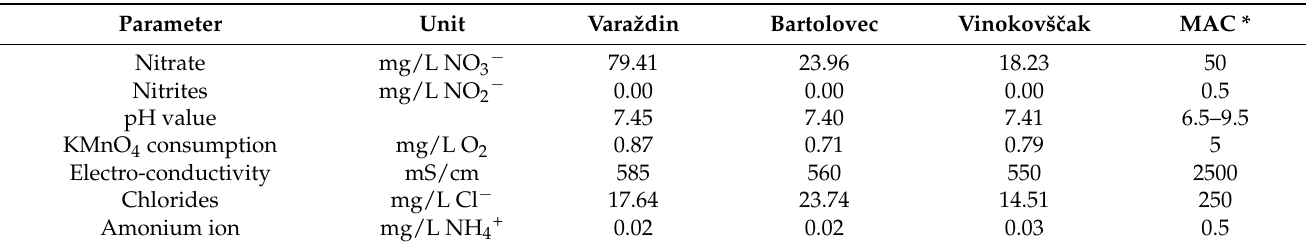
Table 1. Arithmetic means of certain groundwater quality parameters at the observed wellfields in the period